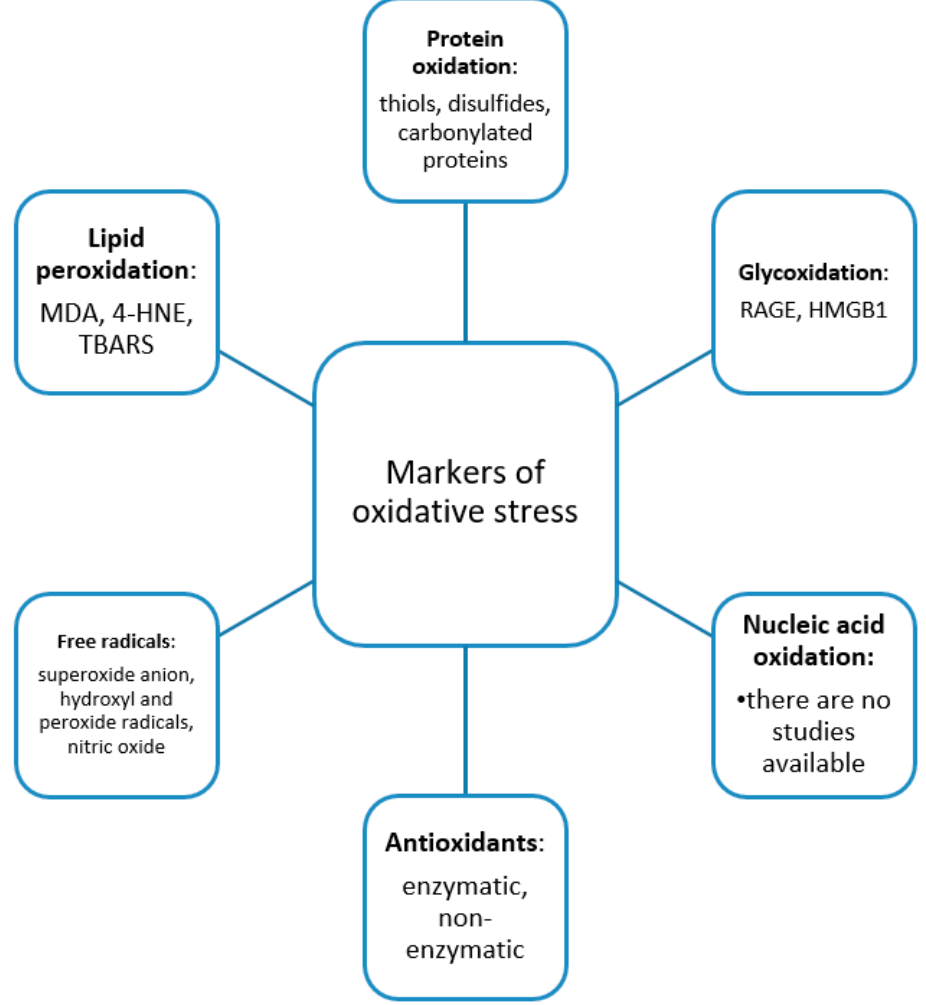
Figure 3. Summary of the oxidative stress markers evaluated in CLP patients, in the studies we have identified, encompassing the categories: markers of lipid peroxidation, oxidation of carbohydrates, proteins and nucleic acids, antioxidants, and free radicals.